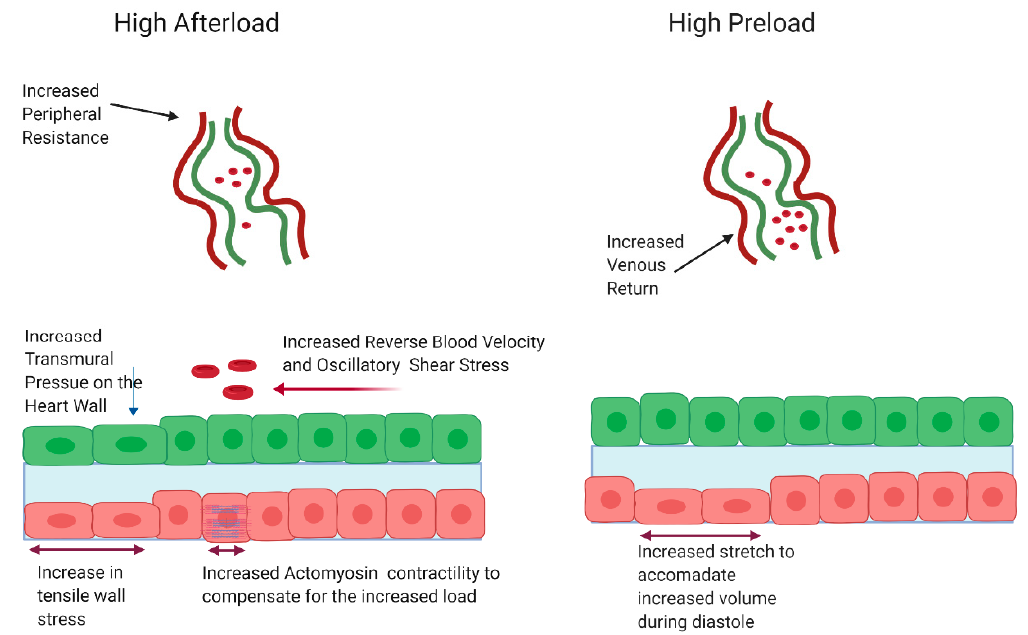
Figure 3. High afterload induces oscillatory shear stress, compressive pressure, and increased contractility resulting in increased tensile wall stress. High preload leads increased stretch to accommodate higher blood volumes during diastole. Figure created with BioRender.